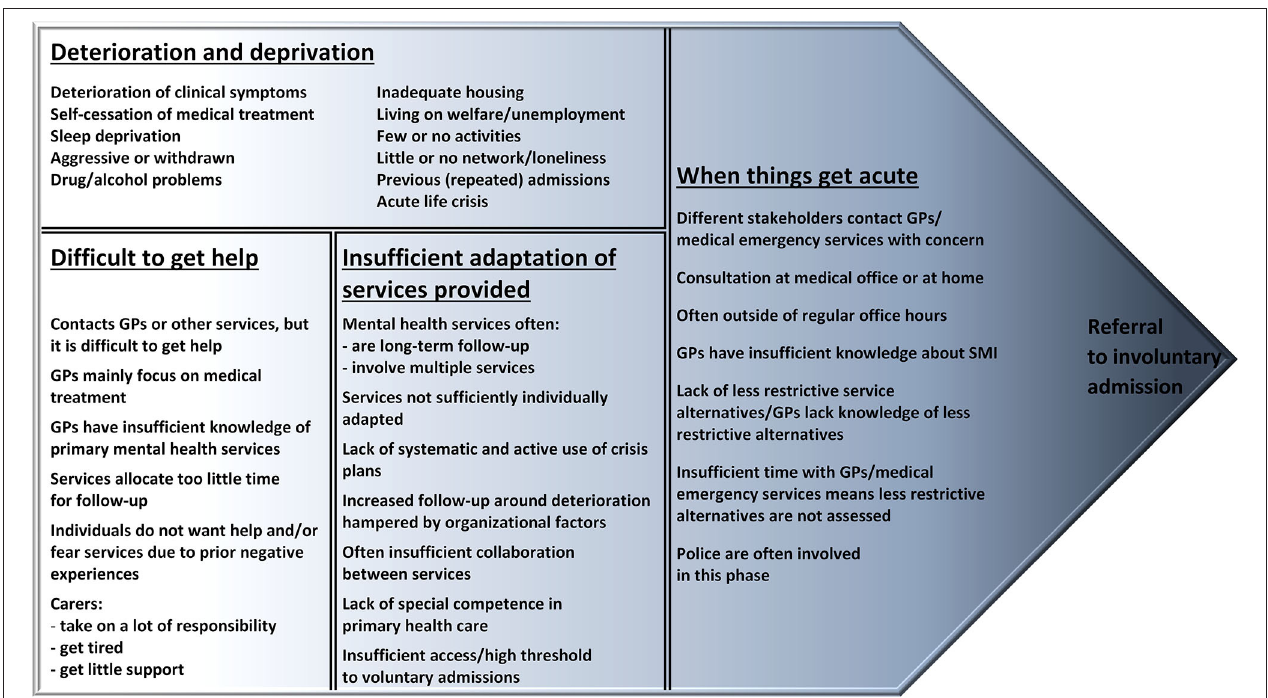
FIGURE 1 | Between no help and coercion: Toward referral to involuntary psychiatric